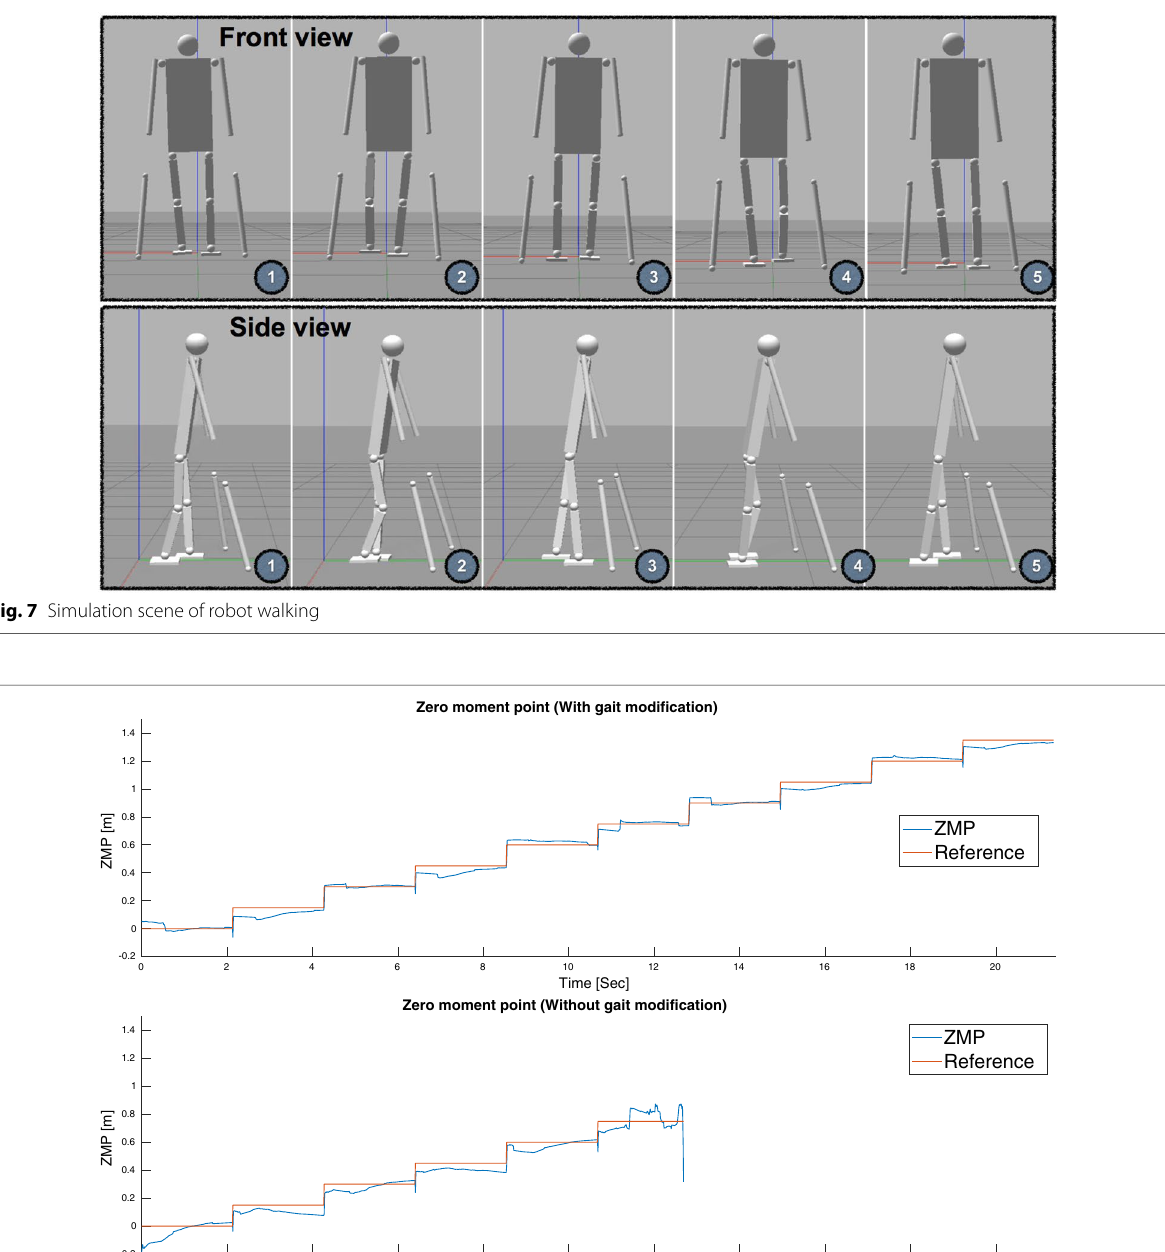
Fig. 8 Comparison between robot walking with and without gait